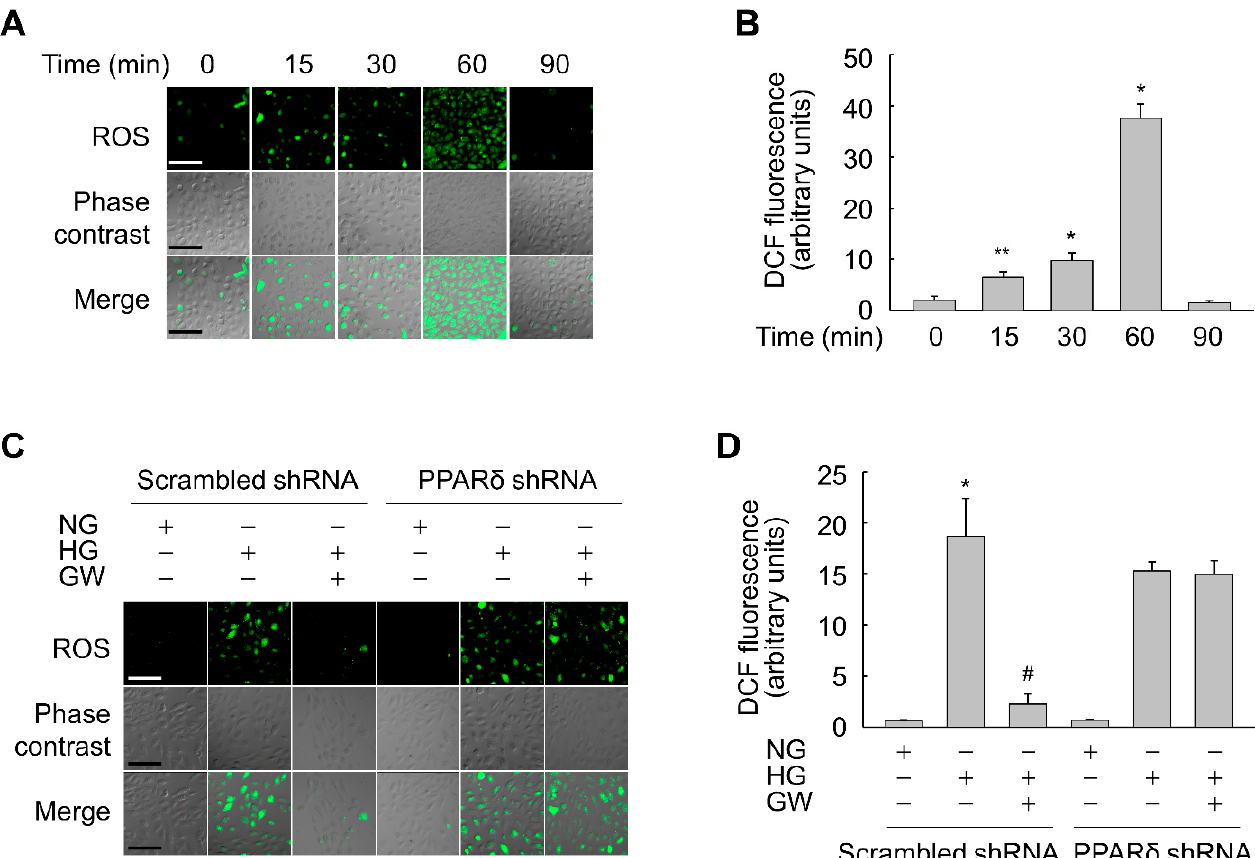
Figure 6. Ligand-activated PPAR δ suppresses HG-triggered ROS generation in ARPE-19 cells. ( A , B ) Cells were incubated in the presence of 30 mM glucose for the indicated durations. ( C , D ) Cells stably expressing scrambled or PPAR δ -targeting shRNA were pretreated with 100 nM GW501516 (GW) for 24 h and then exposed to NG (5.6 mM) or HG (30 mM) for 1 h. Following treatment with 10 μ M CM-H2DCF-DA for the final 30 min, DCF fluorescence, which corresponded to the level of ROS, was detected by confocal laser fluorescence microscopy ( A , C ) and quantified ( B , D ). Scale bars indicate 100 µ m. Representative images from three independent experiments are shown. The fluorescence intensity of DCF is expressed as means ± S.E. ( n = 4). * p < 0.01, ** p < 0.05 compared with 0 min or the NG-treated group. # p < 0.01 compared with the HG-treated group.